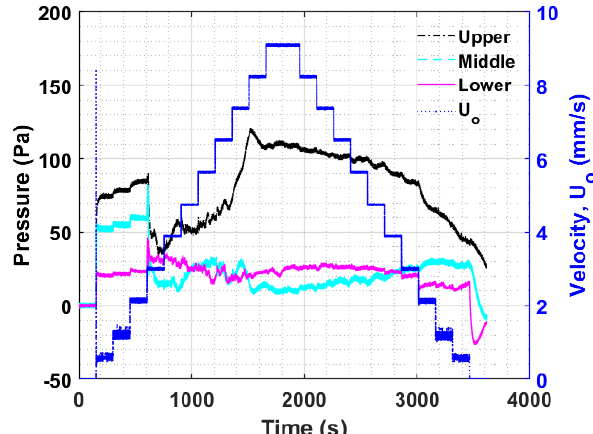
Figure 5. Velocity and pressure transients in different region of the fluidized bed.